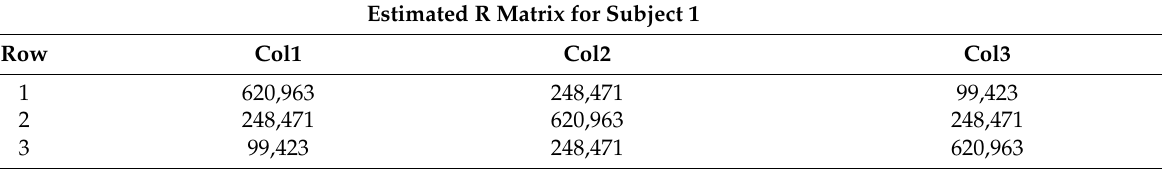
Table 3. Output 3: Partial output of the statistical analysis for the corn study with year treated as a repeated